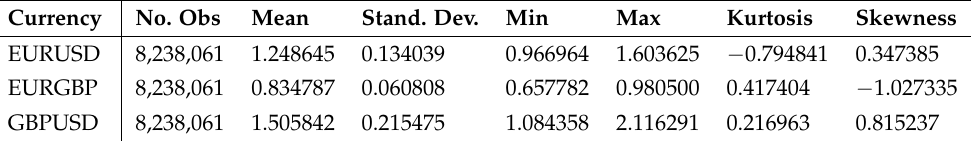
Table 2. Summary of the main descriptive statistics for each currency pair—EURUSD, EURGBP, and GBPUSD—from January 2007 to September 2022. Data shown are from the open bid price rates. Currency No. Obs Mean Stand. Dev. Min Max Kurtosis Skewness EURUSD 8,238,061 1.248645 0.134039 0.966964 1.603625 − 0.794841 0.347385 EURGBP 8,238,061